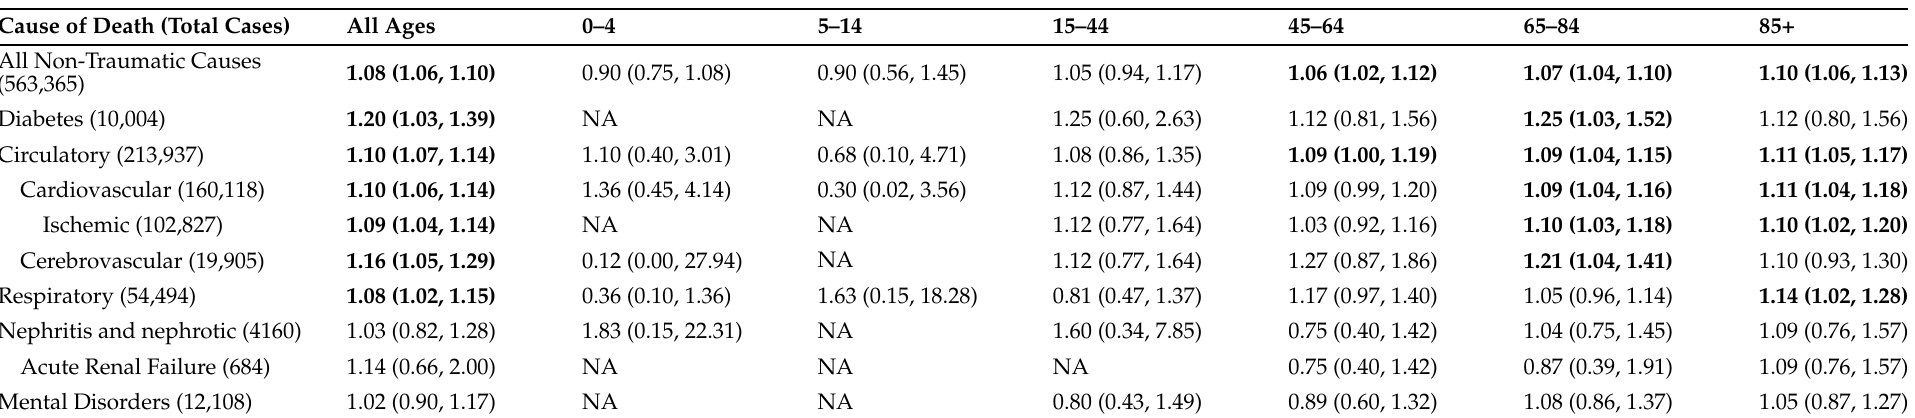
Table 4. Odds ratio (95% CI) of non-traumatic mortality comparing the 99th and 50th percentiles of humidex, by age group and cause of